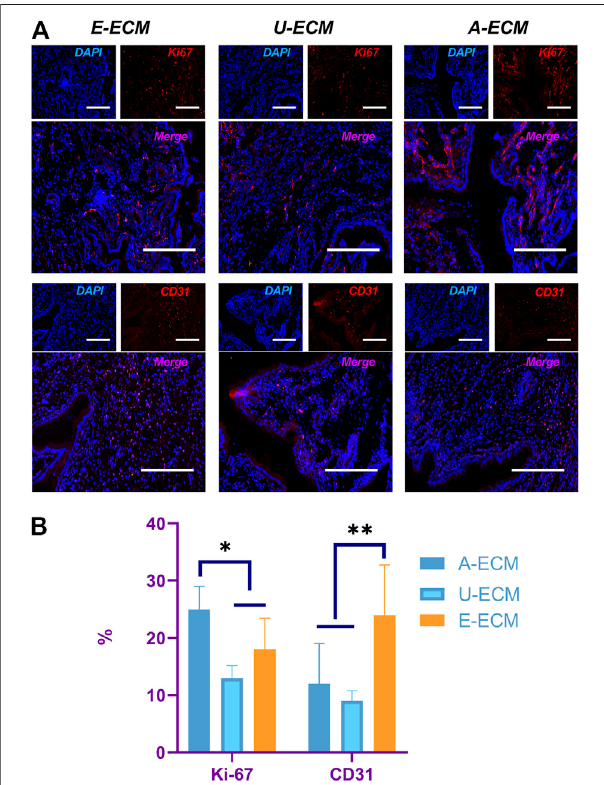
FIGURE 7 | Protein expression of cytokeratin 18 (CK18) and vimentin in regenerative endometrial tissues. At postoperative week 4 (A,B) , CK18 and vimentin immunohistochemistry analyses were used to compare the regeneration of endometrial epithelial cells and stromal cells among all the groups. * p < 0.05 and # p > 0.05, one-way ANOVA with Tukey ’ s post hoc test. Bar = 50 μ m.